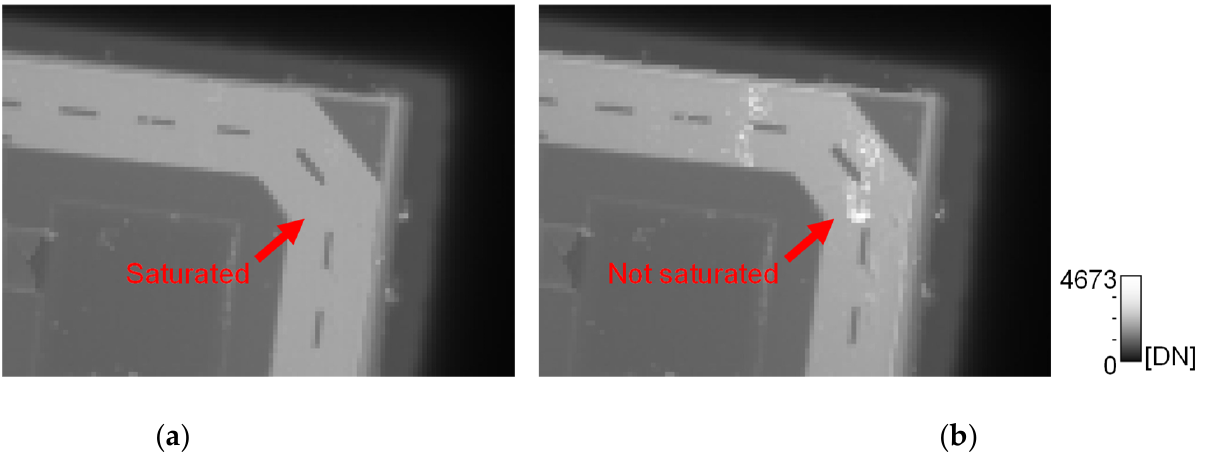
Figure 16. Comparison of images captured of a general-purpose IC chip with the sensor operating in normal mode and HDR mode: ( a ) Normal mode; ( b ) HDR mode.